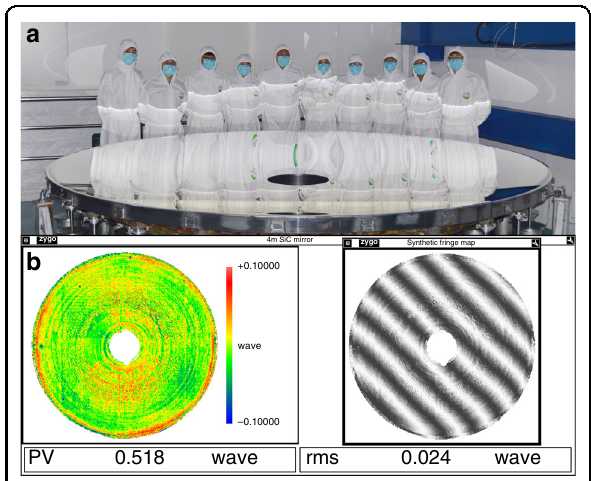
Fig. 1 ⌀ 4.03 m SiC aspheric mirror manufacturing results. a Picture of the world ’ s largest SiC aspheric mirror. b Test result and interferogram of the ⌀ 4 m SiC aspheric